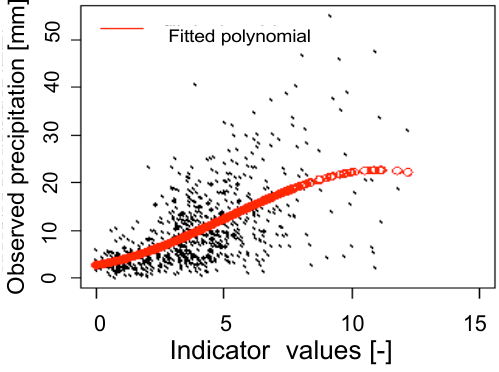
Figure 4: Precipitation versus natural area indicator for Figure 4. Precipitation versus natural area indicator for 1.1.2007. A 3rd order fit, which maximizes the correlation between trend- value and observation is shown (correlation coe ffi cient =